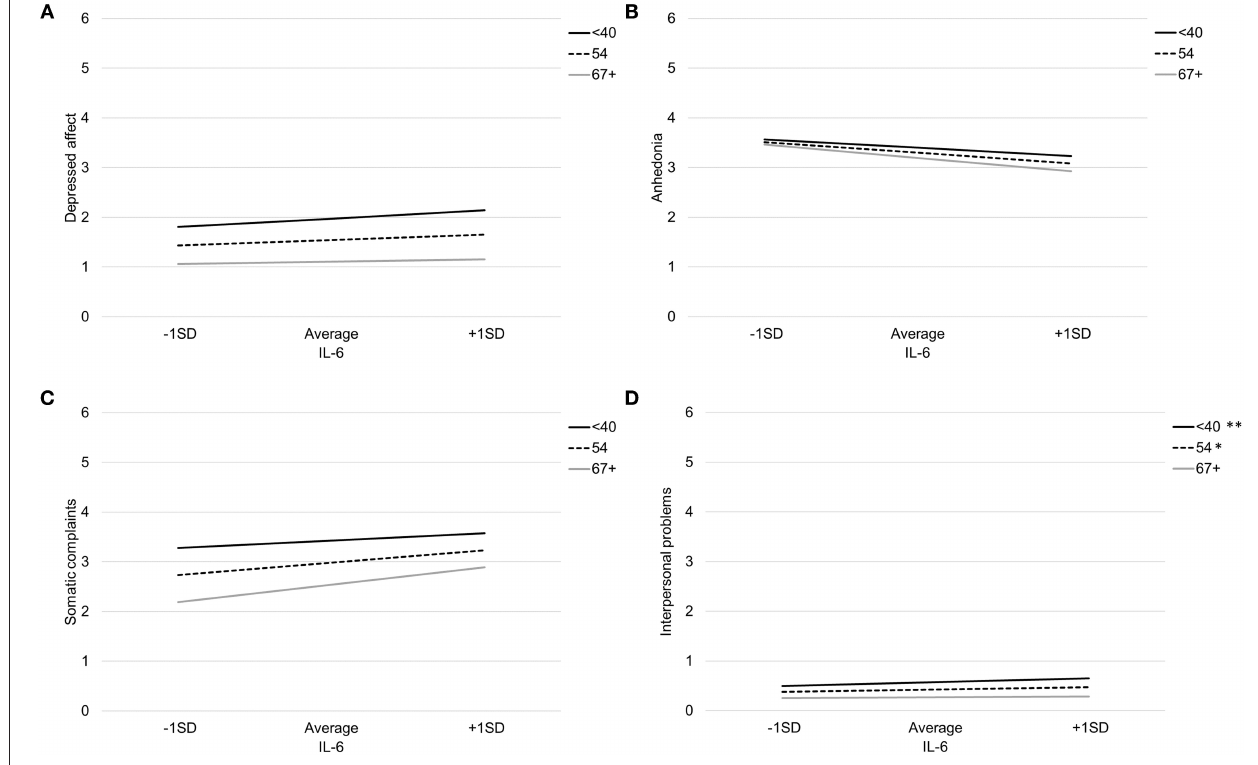
FIGURE 2 | Association between IL-6 and depressed affect (A) , anhedonia (B) , somatic complaints (C) , and interpersonal problems (D) by age. Note: ** p < 0.007, * p < 0.05.